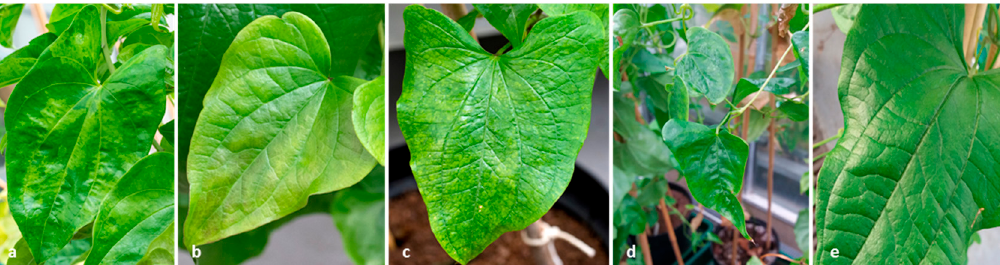
Figure 4. Yam leaf samples used in this study showing typical yam mosaic disease symptoms; ( a ) D. rotundata TDr 99 / 02674 showing mosaic symptoms; ( b ) D. rotundata cv. Adaka showing chlorotic leaf discoloration and ( c ) mottling; ( d ) D. rotundata TDr 00 / 00168 showing leaf deformation; ( e ) Asymptomatic D. rotundata cv. Adaka. ( a – d ) Plants tested positive for YMV, whereas YVY was detected in all the plants ( a – e